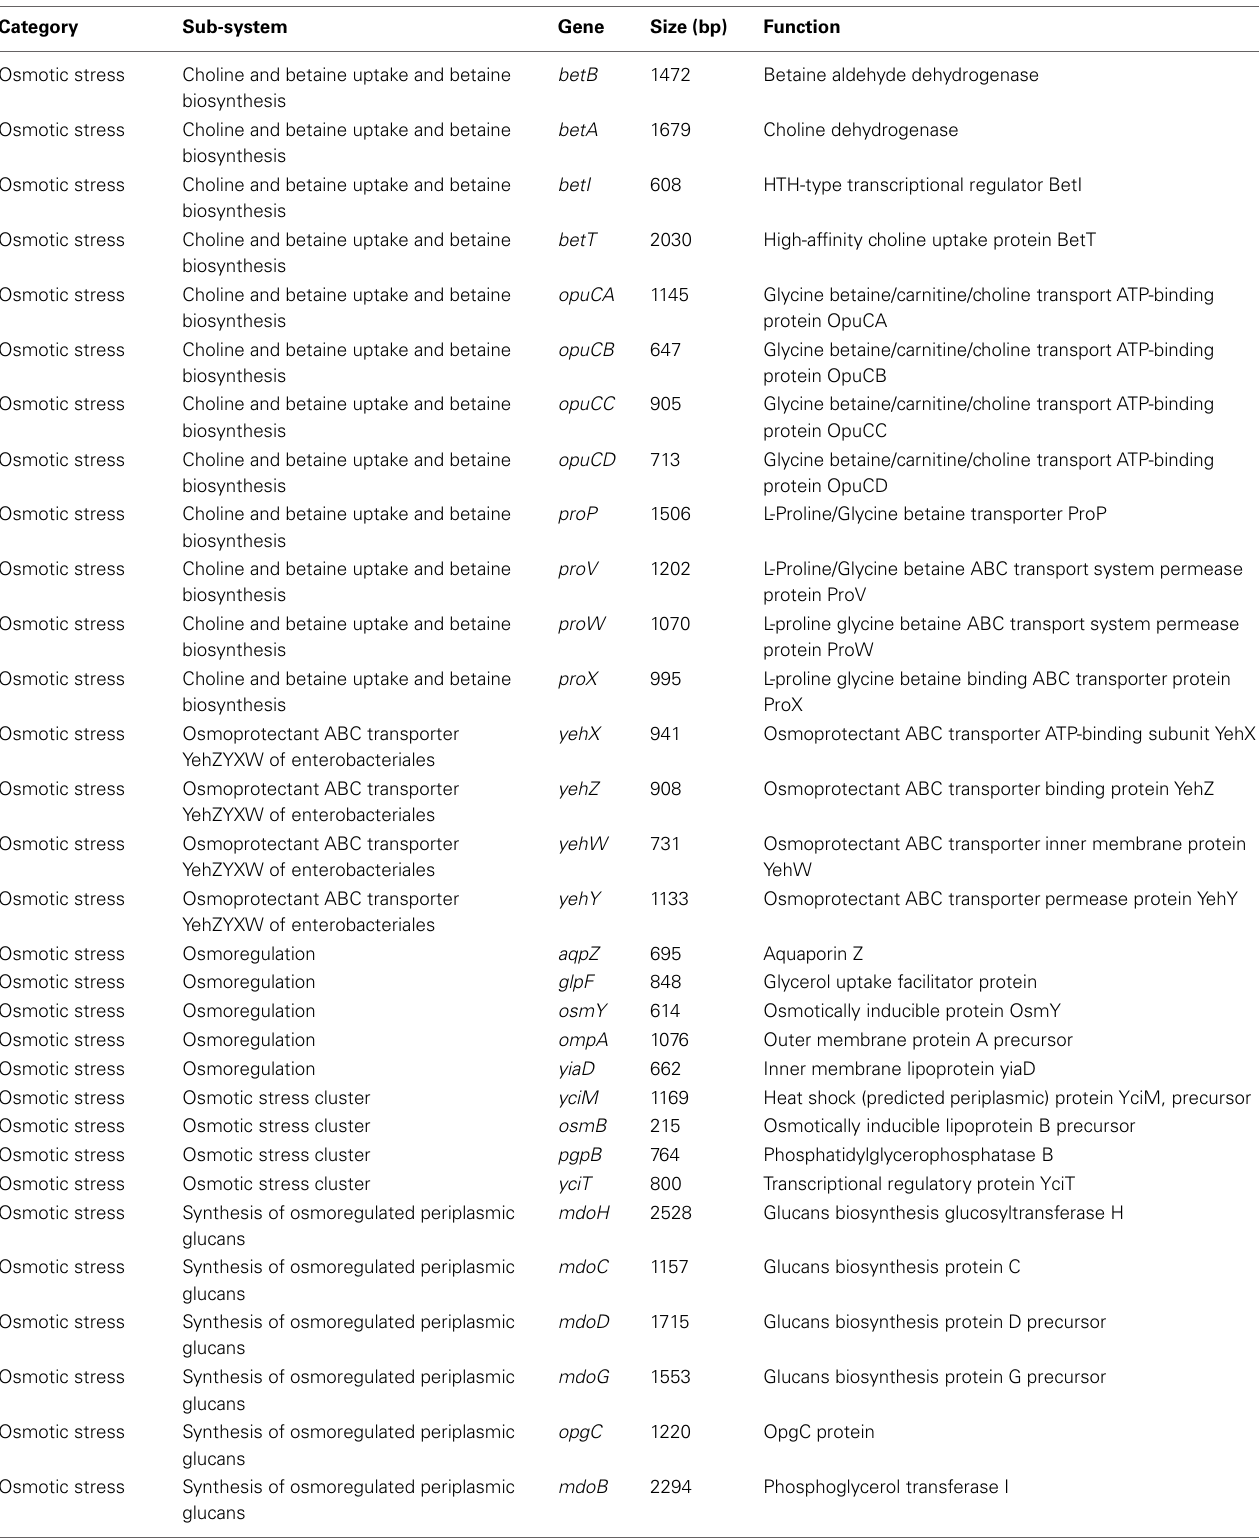
Table 4 | A selection of the stress response-encoding genes, the defined sub-system, together with the gene name, length of the ORF and correspondoing function, identified in C. sakazakii